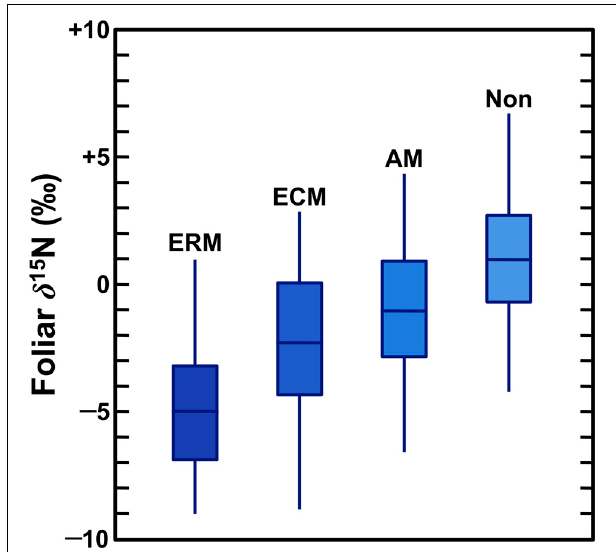
FIGURE 2 | Foliar N isotopic compositions of plants according to mycorrhizal associations (Craine et al., 2009b). Boxes represent interquantile (25–75%) ranges, bars dividing boxes represent means, vertical lines represent 95% of the data. As described in Craine et al. (2009b) data were normalized to a common temperature, precipitation, and foliar [N]. ERM, ericoid; ECM, ectomycorrhizal; AM, arbuscular; Non,